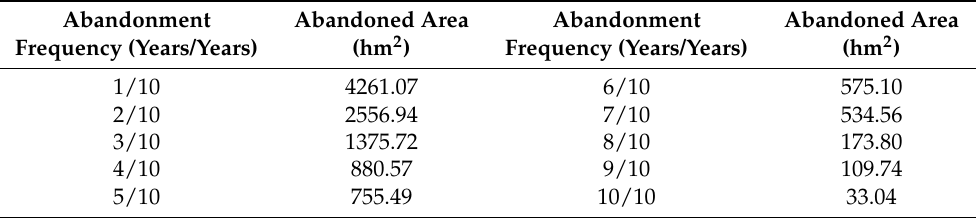
Table 5. Statistics of the farmland abandonment frequency in Luquan for the period of